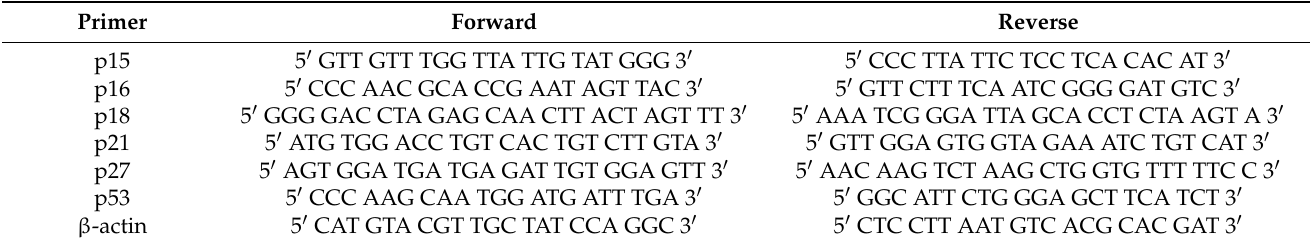
Table 1. Primers sequences used for quantitative PCR analysis of gene